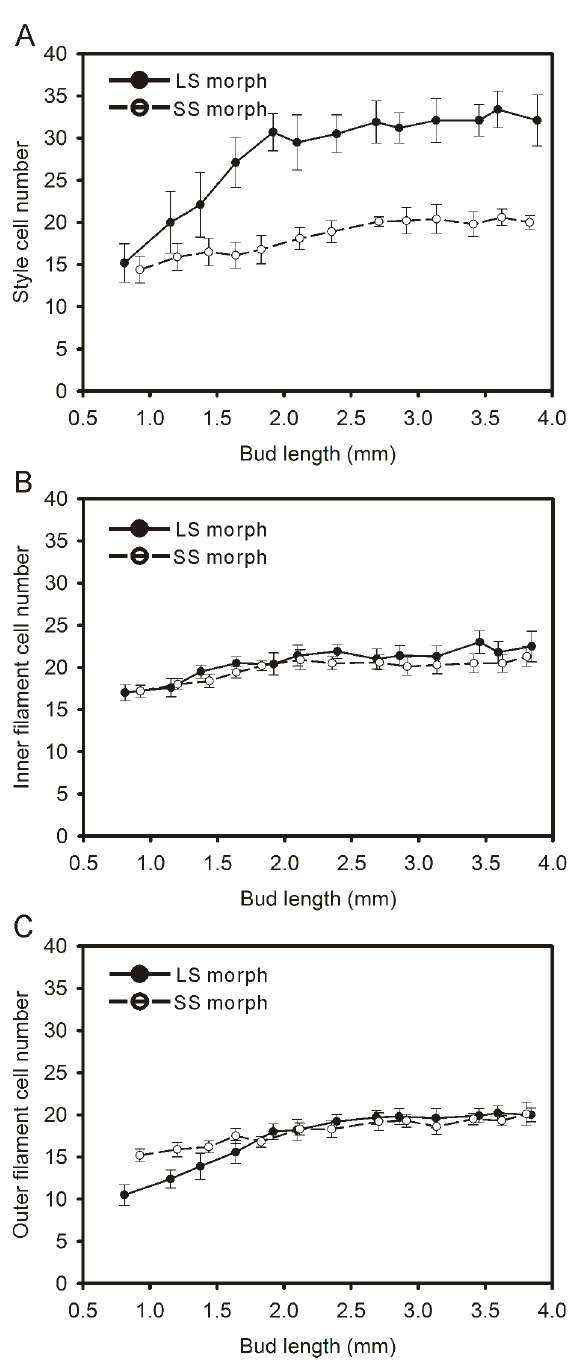
Figure 4. The development of styles and filaments in two morphs of Polygonumjucundum . A, Style; B, Inner filament; C, Outer filament. Regression lines were fitted separately to the data for each floral morph.